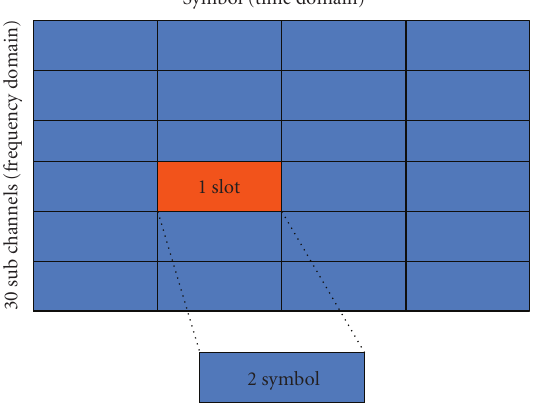
Table 1: (a) Theoretical throughputs. (b) MCS